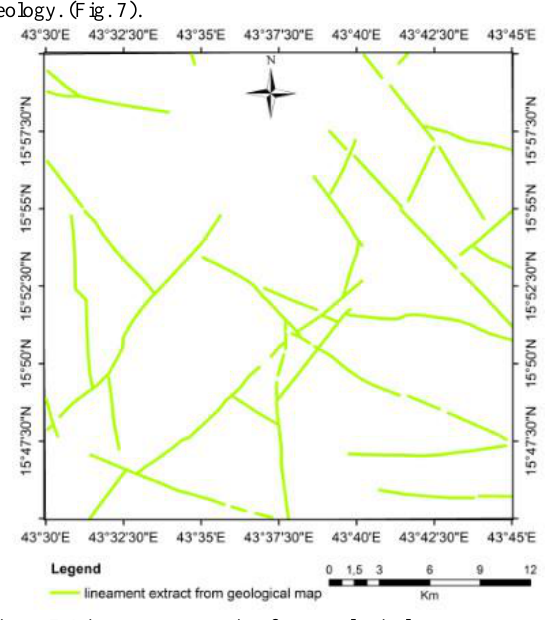
we get 172 lines comparing with another method we get only 49 line from the geological map.